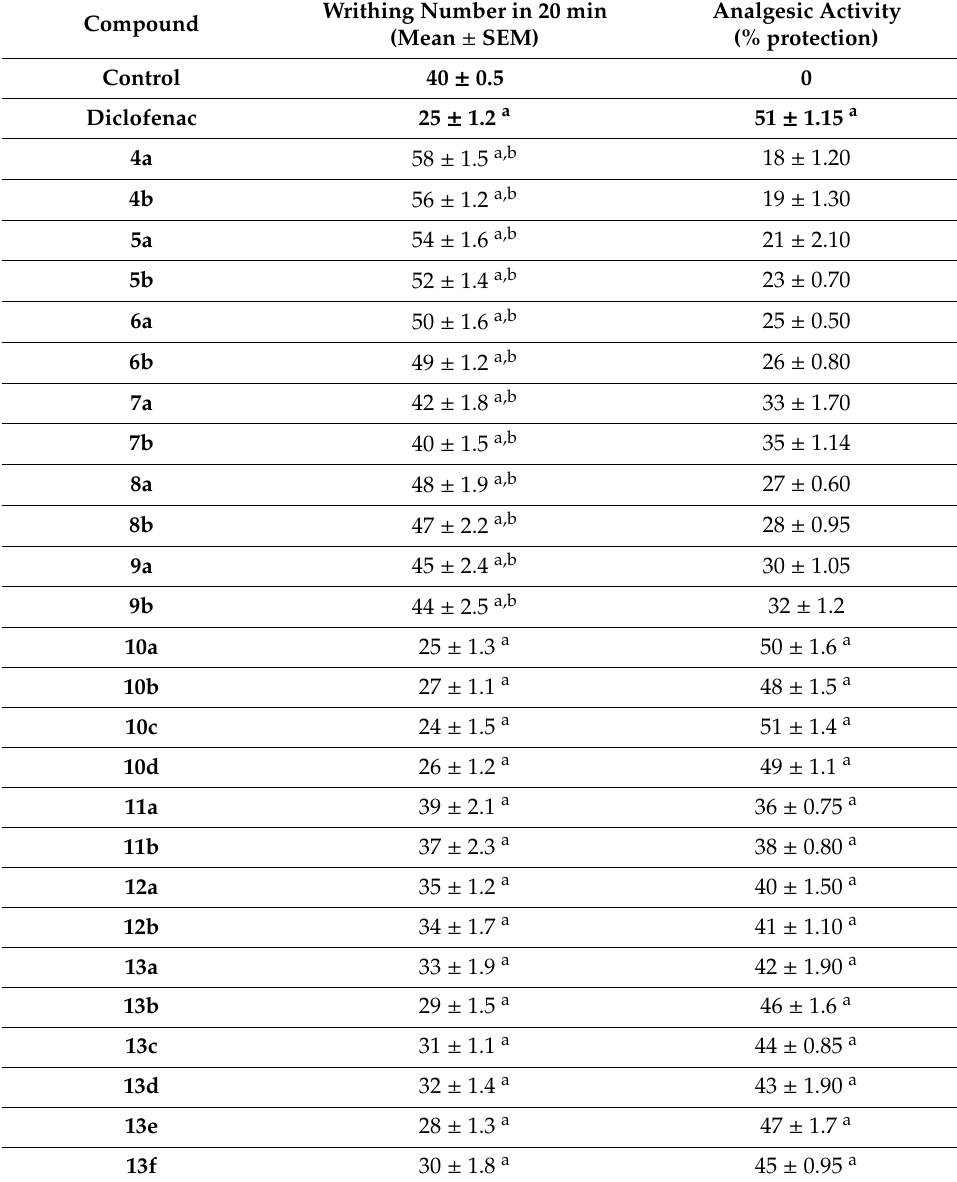
Table 2. Analgesic activity of the compounds using the writhing